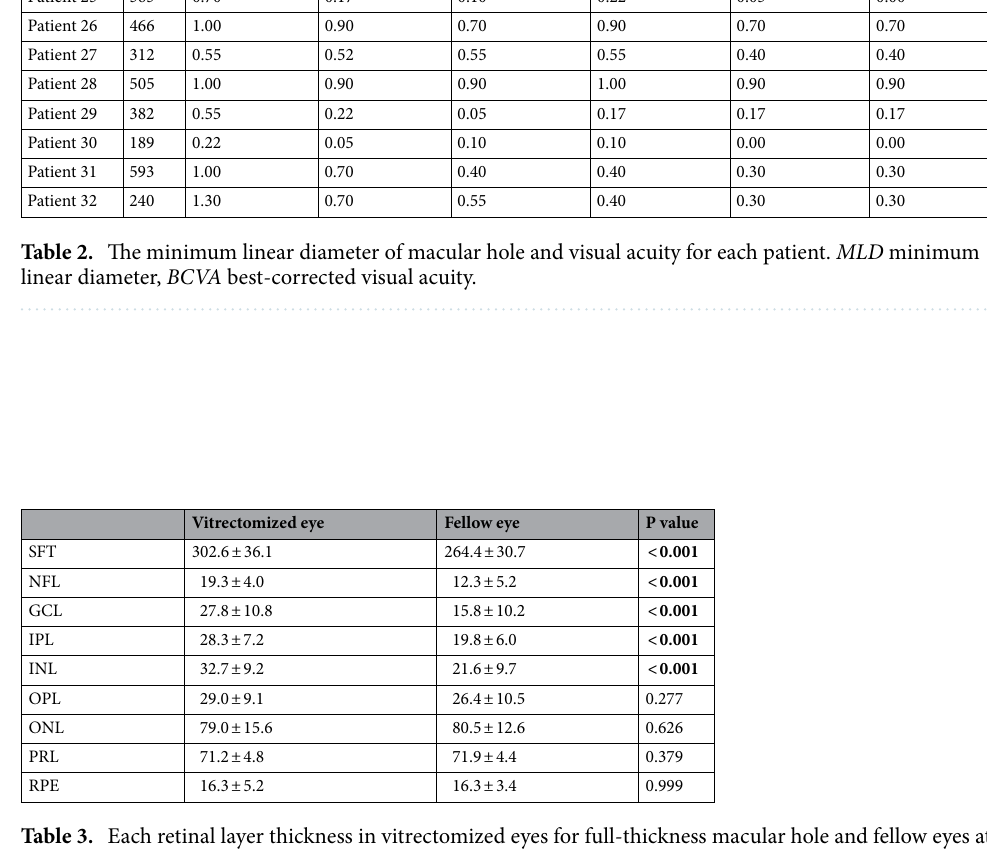
Table 3. Each retinal layer thickness in vitrectomized eyes for full-thickness macular hole and fellow eyes at 12 months after surgery. All values are expressed as the mean ± standard deviation (μm). Values in boldface are statistically significant ( P < 0.050). SFT subfoveal thickness, NFL nerve fiber layer, GCL ganglion cell layer, IPL inner plexiform layer, INL inner nuclear layer, OPL outer plexiform layer, ONL outer nuclear layer, PRL photoreceptor layer, RPE retinal pigment